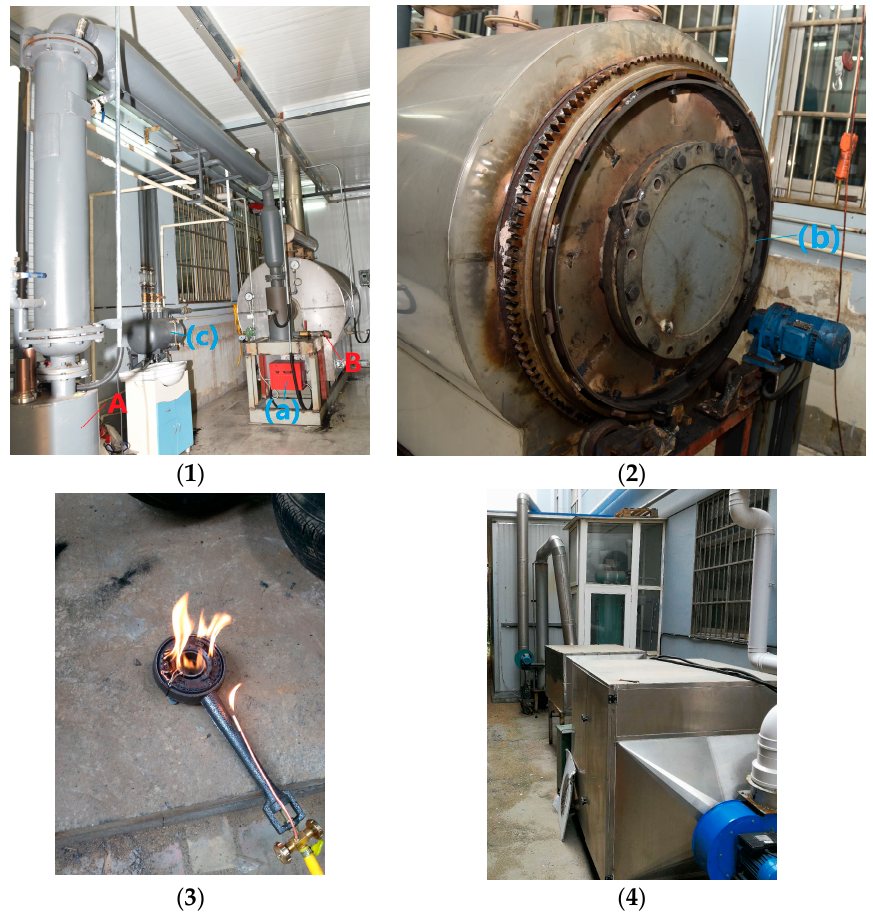
Figure 1. The pilot test device for industrial cracking of DN1000: ( 1 ) the main structure, ( 2 ) the gear drive, ( 3 ) the condensable gas combustion, and ( 4 ) the exhaust gas treatment.